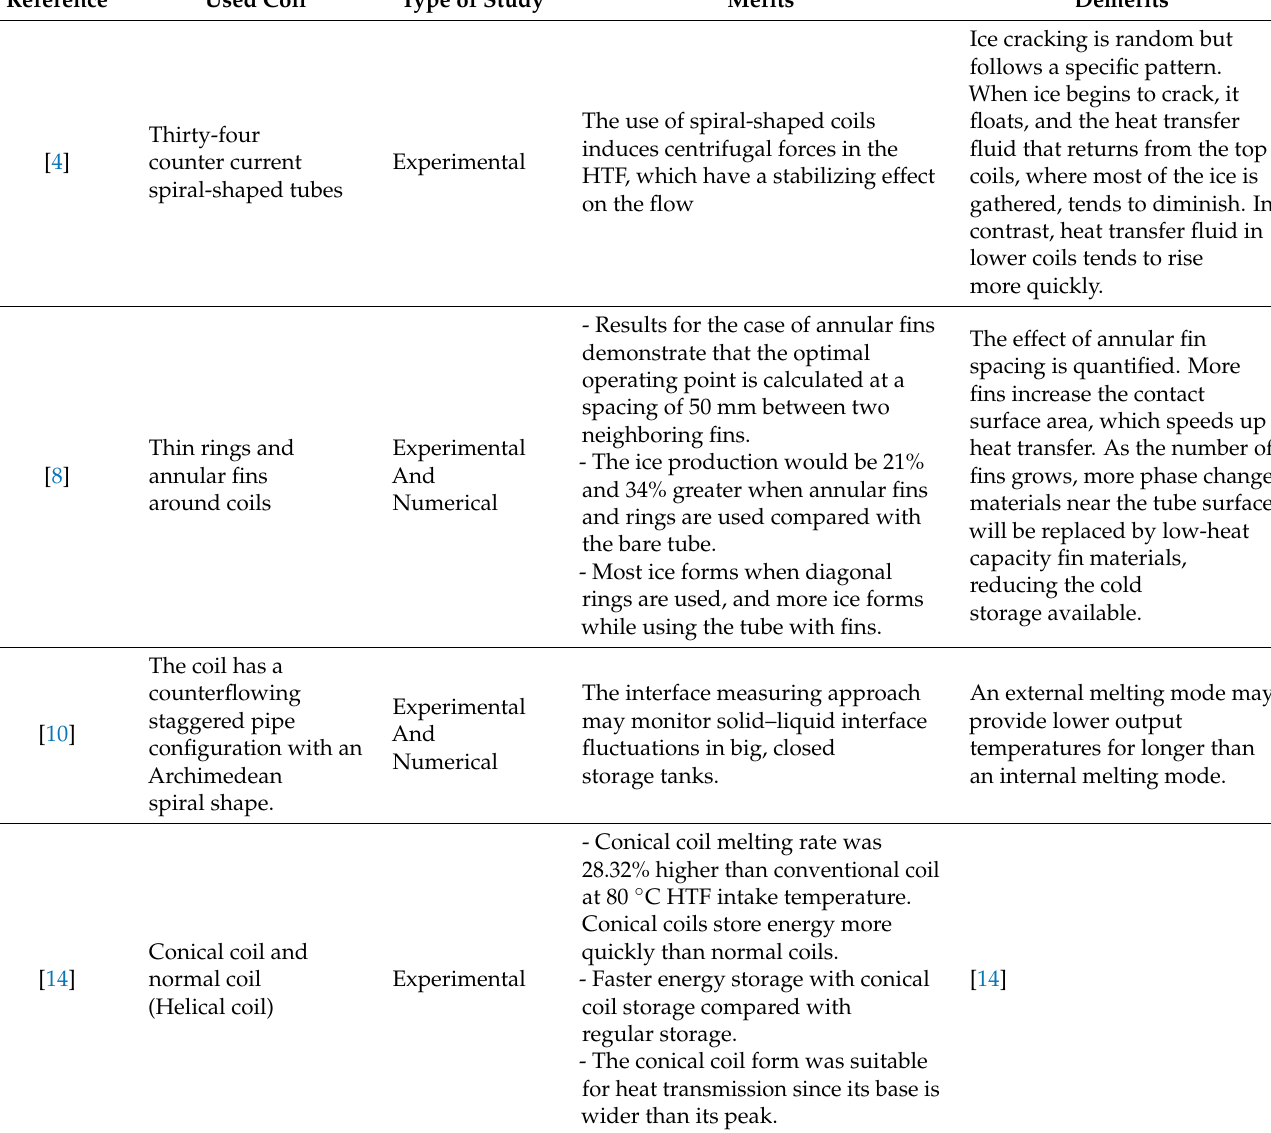
Table 1. Merits/demerits of different shaped coils used in